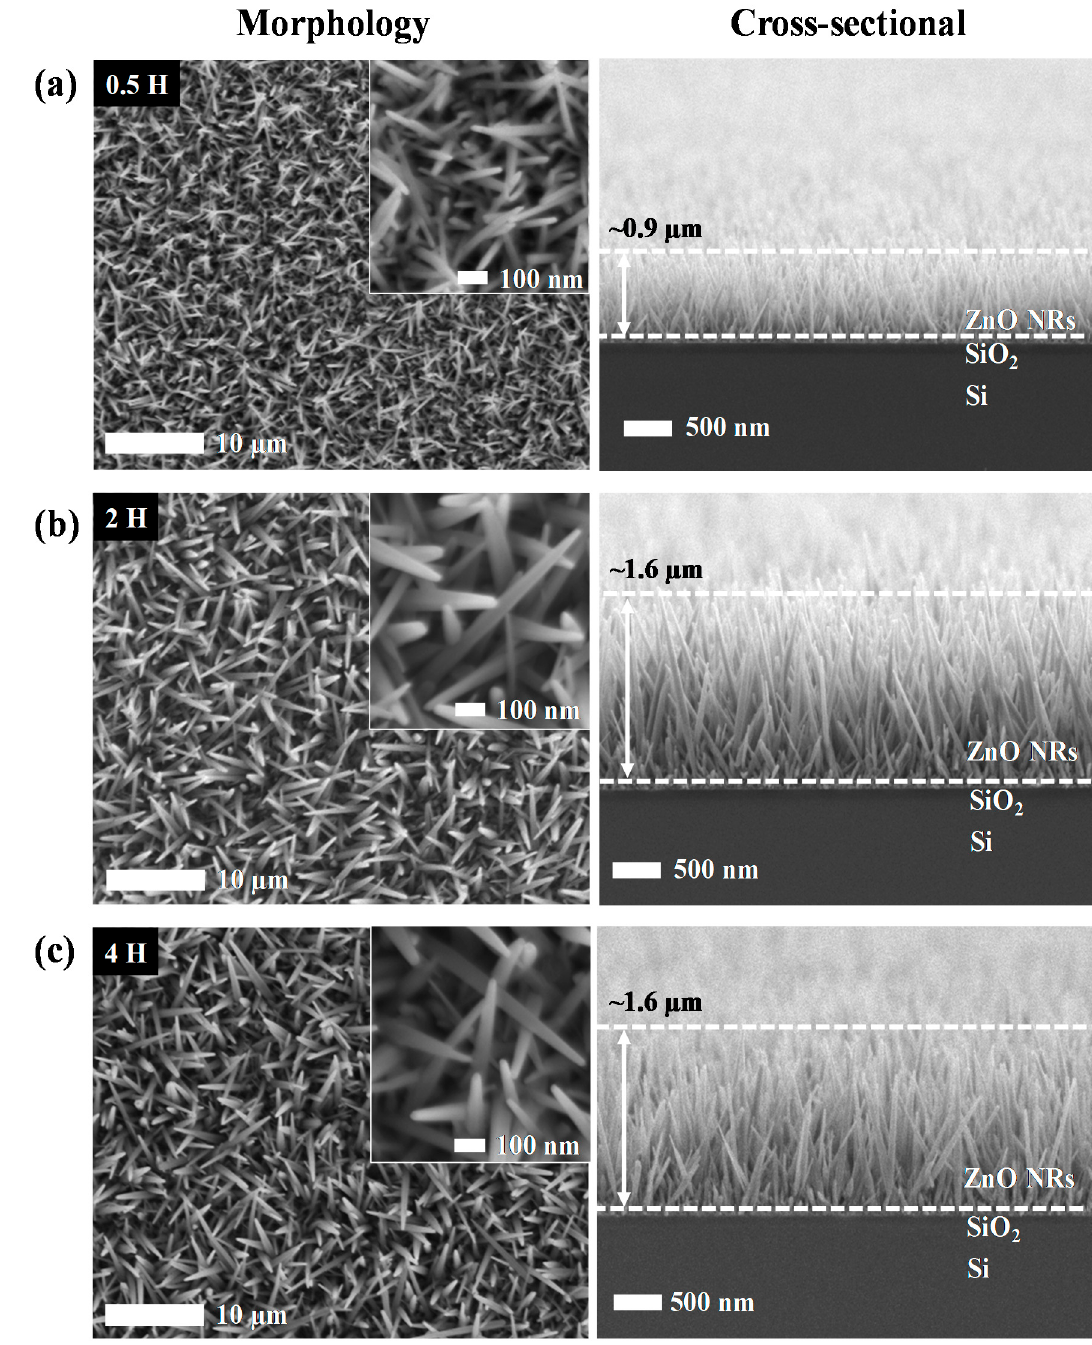
Figure 1. Field emission scanning electron microscopy (FESEM) images of the ZnO NRs after immersion time of ( a ) 0.5 h, ( b ) 2 h, and ( c ) 4 h with different magnification in between their morphological and cross-sectional images.